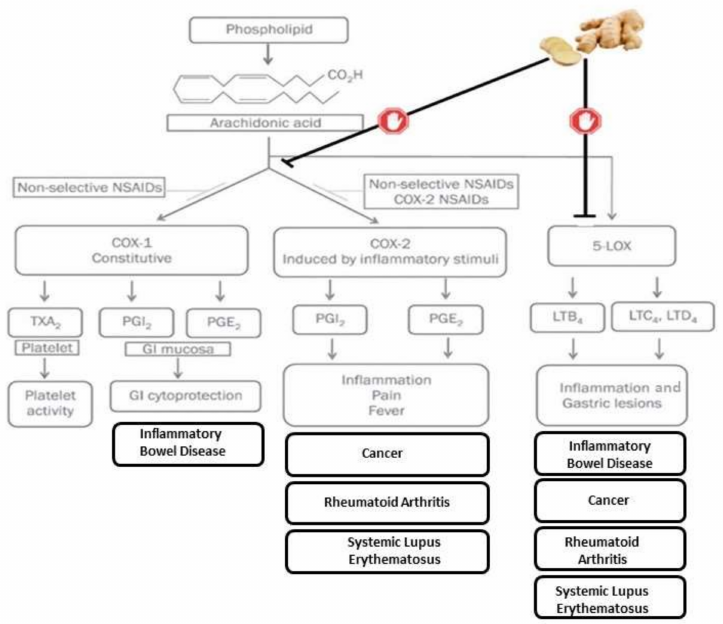
Figure 1. Inflammation, ginger actions, and its relationship with disease etiology and